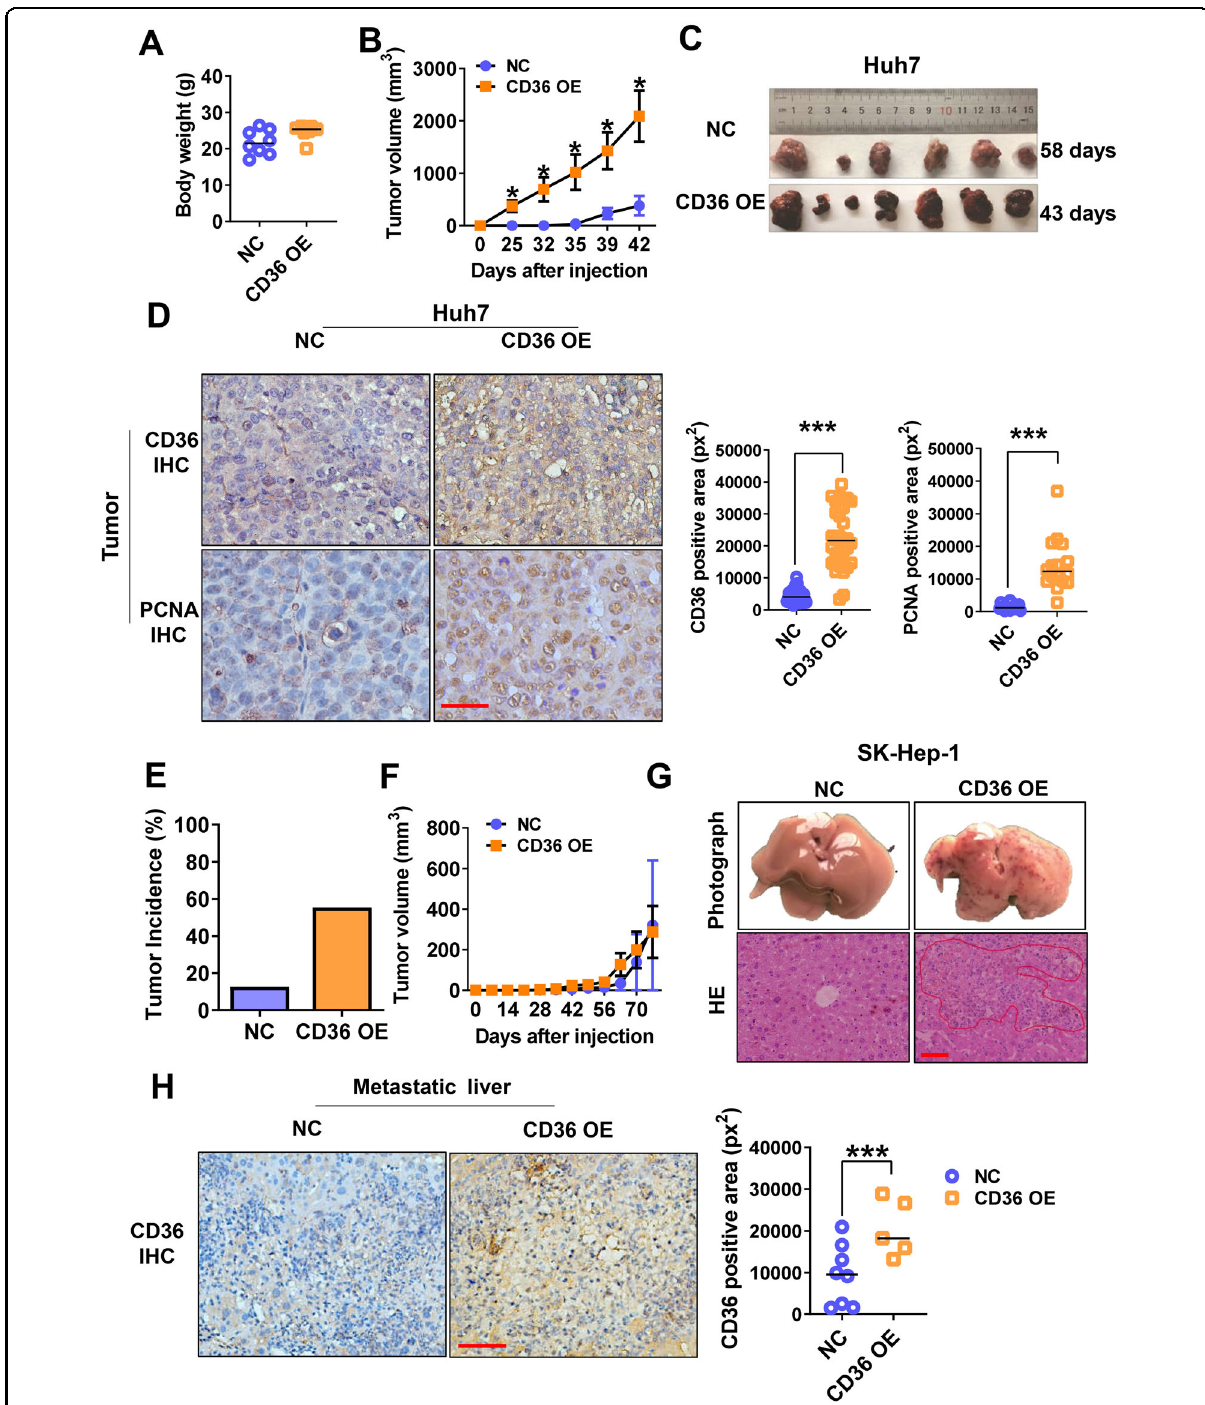
Fig. 4 CD36 overexpression aggravates HCC growth and metastasis in mouse xenograft model. CD36 OE or control cells (1×10 6 ) were subcutaneously injected into the left fl anks of nude mice ( n = 9). The body weight ( A ) and tumor volumes ( B ) of mice injected with Huh7 cells. C Photographs of subcutaneous Huh7 tumors were shown. D IHC analysis of PCNA and CD36 in Huh7 tumors, and the quanti fi cation of CD36-positive and PCNA-positive area was shown on the right. Representative images were shown at ×400 magni fi cation. Tumor incidence ( E ) and tumor volumes ( F ) of mice injected with SK- Hep-1 cells. G The above images were representative images of liver metastases in each group after 70 days. The following images were representative images of HE staining of the metastasized liver sections. Representative images were shown at ×400 magni fi cation. H IHC analysis of CD36 in SK-Hep-1 liver tissue from each group, the quanti fi cation of CD36-positive area was shown on the right. Representative images were shown at ×400 magni fi cation. All data are presented as mean±SD. * P <0.05 and *** p <0.001 compared with the NC group. Bar = 50 μ m ( D , G , H ). P -value was calculated using Student ’ s t